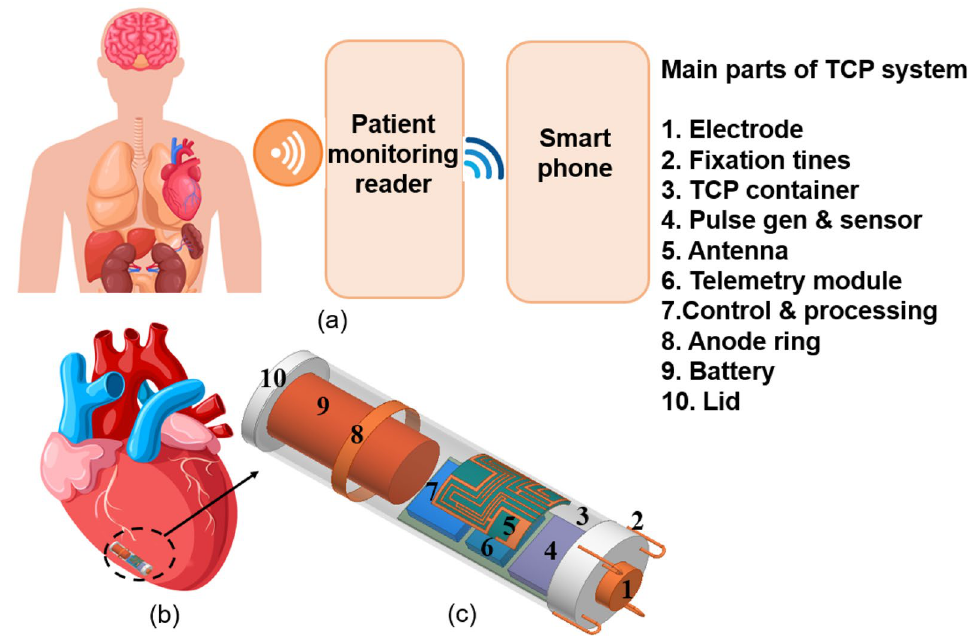
Figure 2. Schematic of the leadless cardiac Transcatheter Pacing (TCP) system ( a ) wireless monitoring of the implanted TCP with patient monitoring reader and data transfer to smart phone ( b ) leadless cardiac TCP implanted inside human heart. (human body figure is adapted from 12